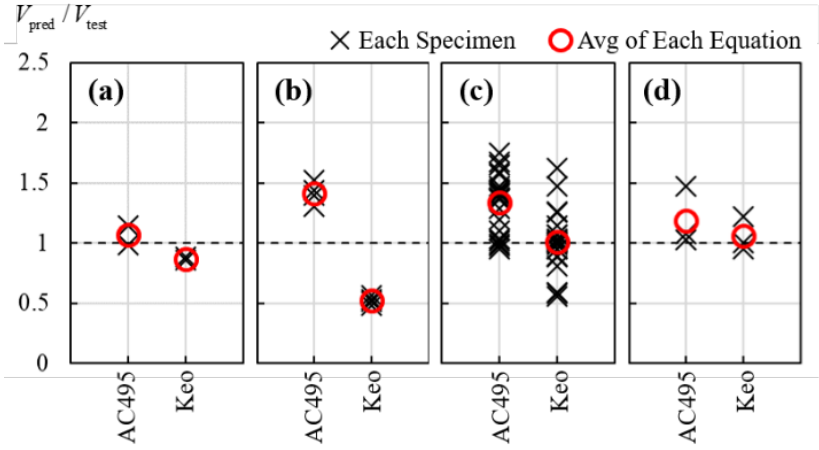
Figure 9. Comparison of Predictions to Tests: ( a ) C-channel Anchors; ( b ) L-channel Anchors; ( c ) In- versed L-channel Anchors; ( d ) Z-channel